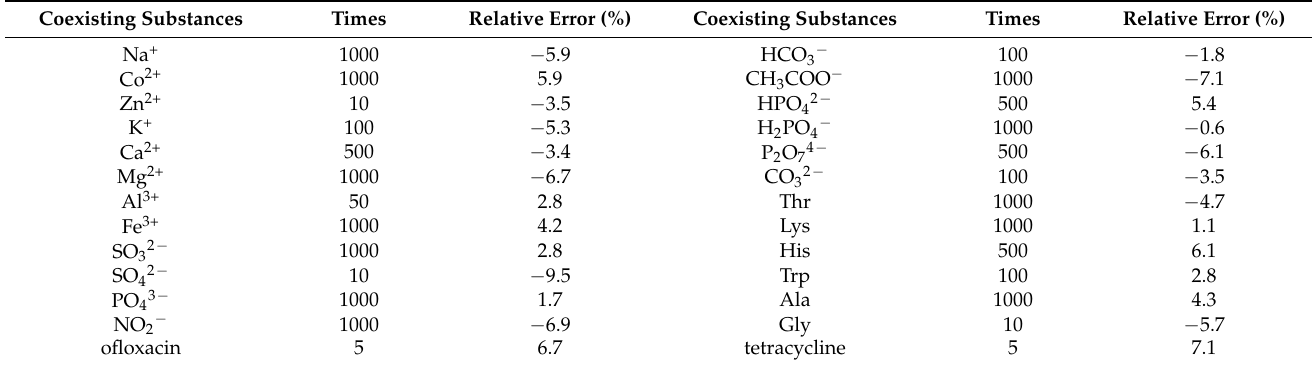
Table A4. Influence of coexistent substances (SERS).